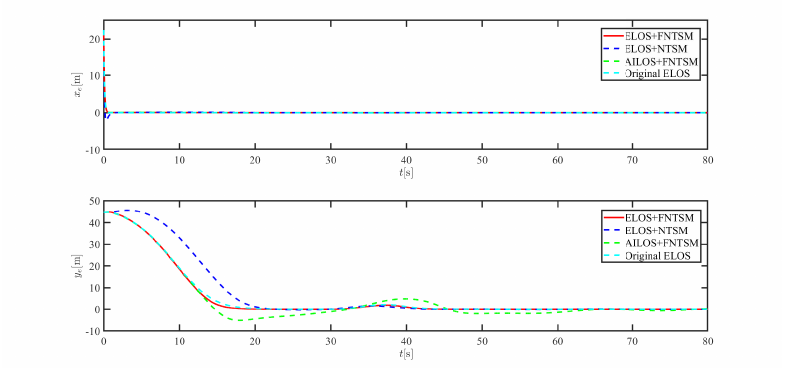
Figure 28. Comparison results of curve line trajectory tracking under severe disturbance.